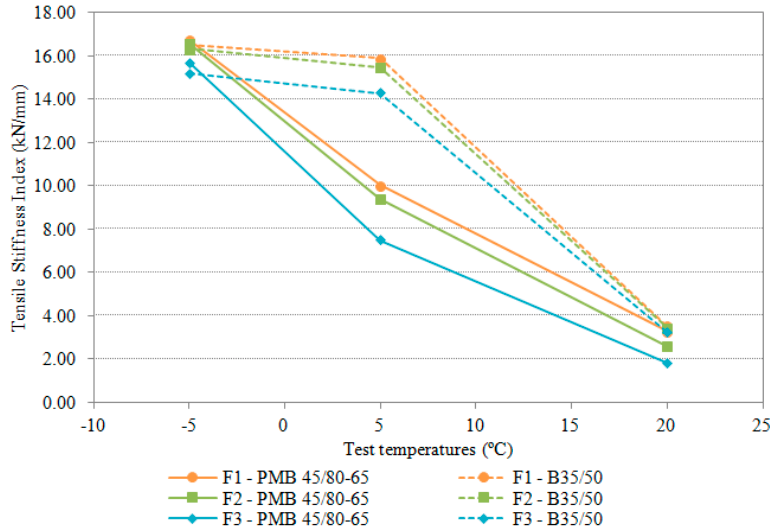
Figure 5. Tensile stiffness index versus temperature.